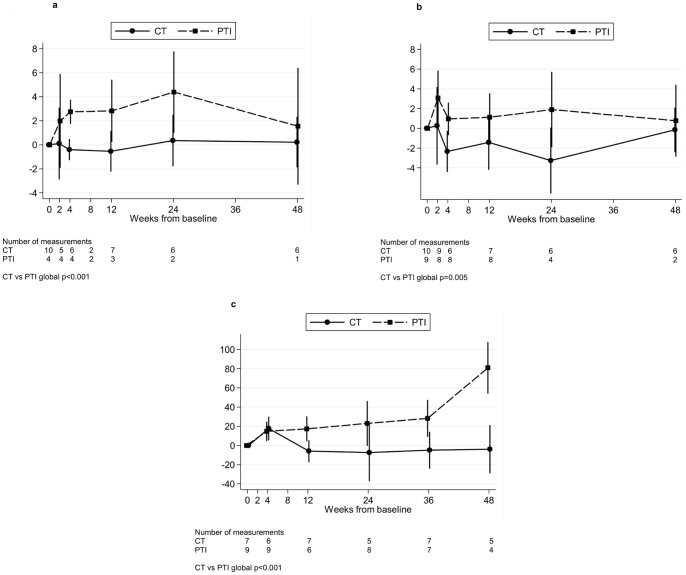
Change in % Ki67, HLA-DR and LPS from baseline.Change in % Ki67 (a) and % HLA-DR (b) in CD45RA- CD31- cells and in LPS (c) from baseline for children in the substudy. CT  =  continuous ART (antiretroviral therapy), PTI  =  planned treatment interruption (off ART). Changes from baseline were estimated using normal regression of actual measurements adjusting for baseline using the overall mean at randomisation as the reference category.